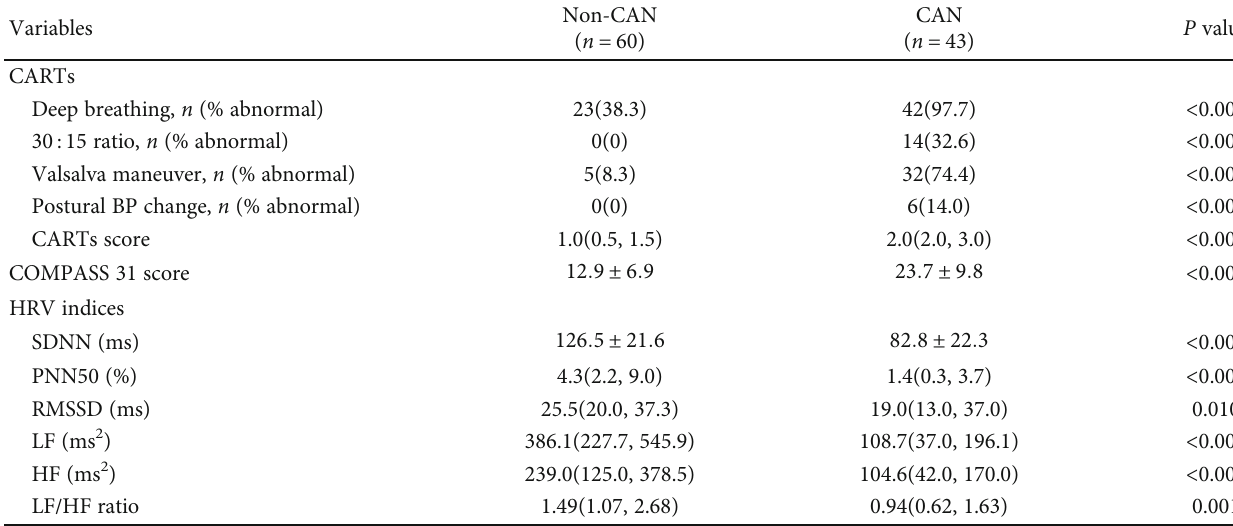
Table 2: The indicators of cardiovascular autonomic nervous function.